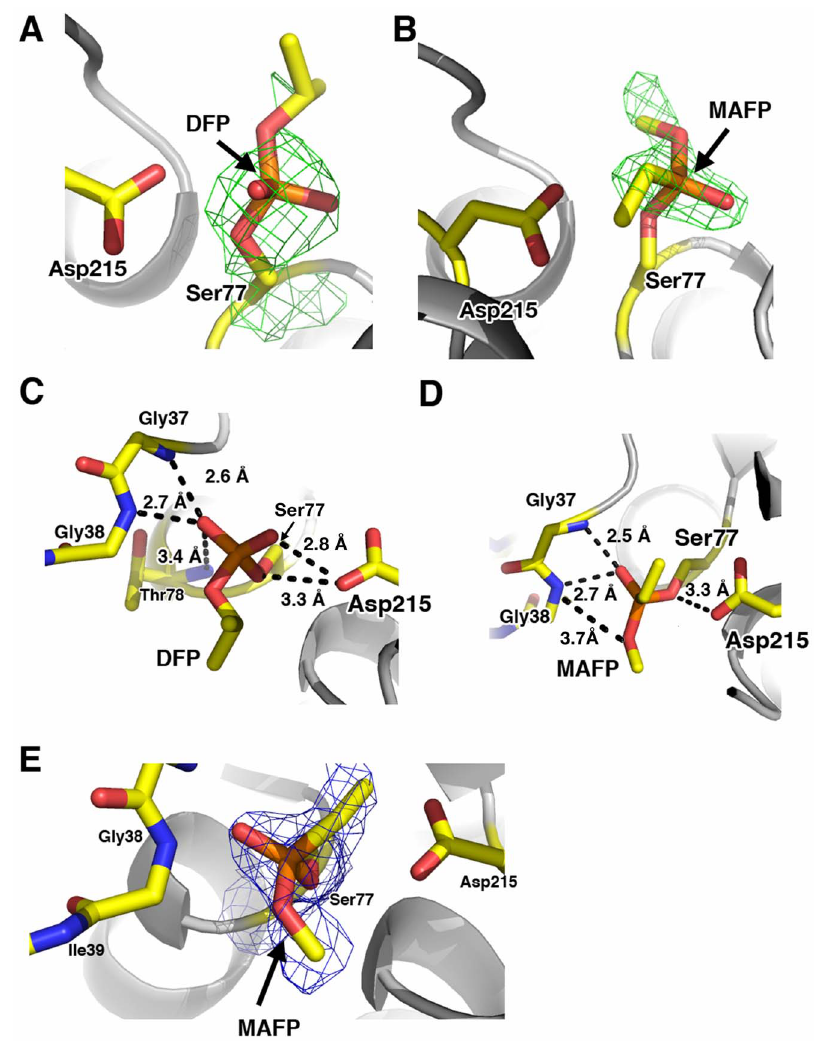
Figure 3. Pat17 bound to OPs. Initial difference ( F o -F c ) maps contoured at 3 s (depicted as a green mesh) showing the positive electron densities around (A) the aged DFP and (B) the non-aged MAFP adducts on the catalytic Ser77 residue of pat17. (C and D) The active site of patatin with (C) the aged DFP and (D) non-aged MAFP adducts showing contact distances between the adducts and the oxyanion hole of pat17 as well as the contact distance between the negatively charged oxygen atoms of the aged DFP and the backbone amide nitrogen of Thr78. For clarity, the orientation of the molecule is a 180 u rotation about the X- and Y-axes in panel A. (E) 2F o -F c electron density (contoured at 1 s ; depicted as a blue mesh) around the catalytic Ser77 residue in complex with MAFP. The active site Ser77 and Asp215 residues as well as the residues that comprise the oxyanion hole of pat17 are rendered as sticks with the following color scheme: yellow = carbon, blue = nitrogen and red = oxygen.